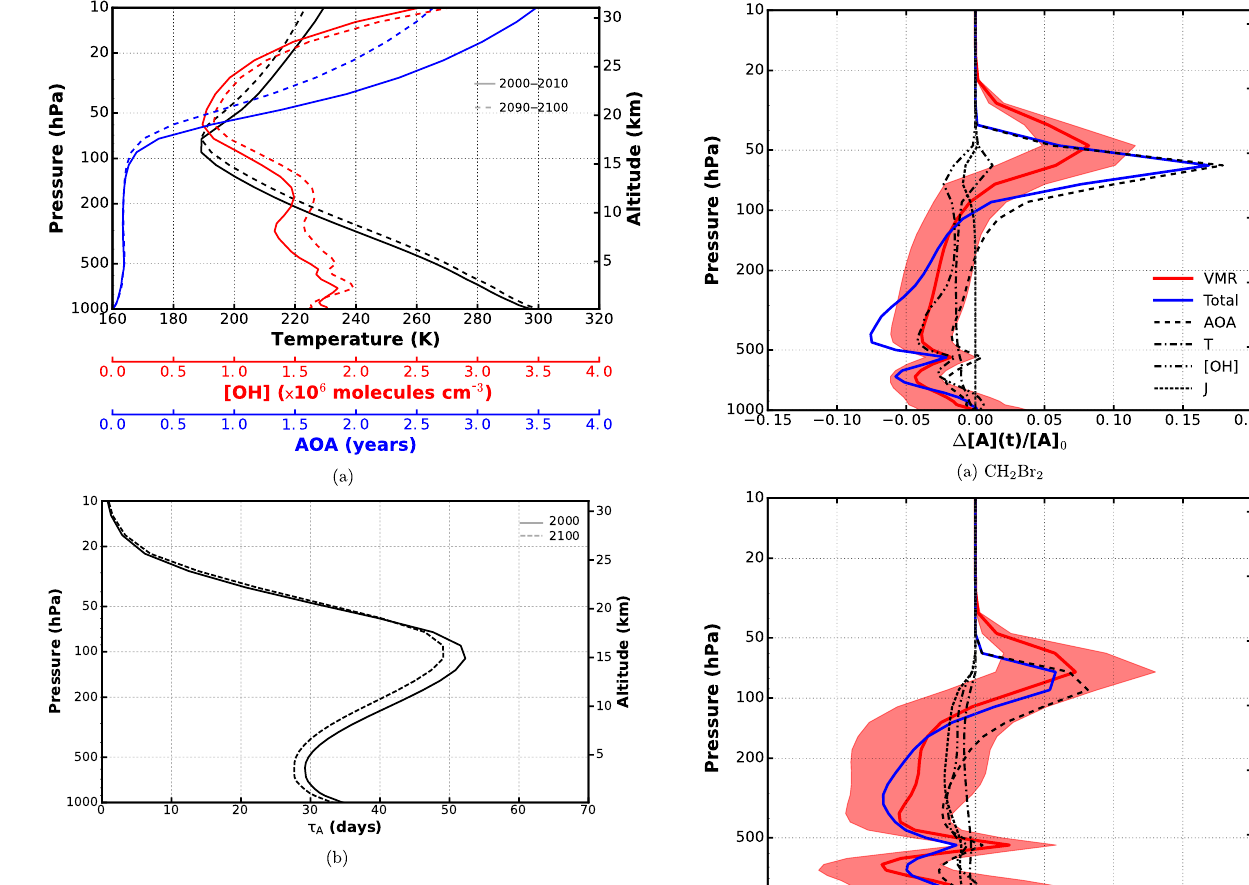
Figure 6. Tropical average profiles from ESCiMo RC2-base-05 simulation of changing variables in Eq. (3) for present day (solid lines) and future (dashed lines). (a) Temperature, OH concentration, and age of air; (b) lifetime of CHBr 3 .